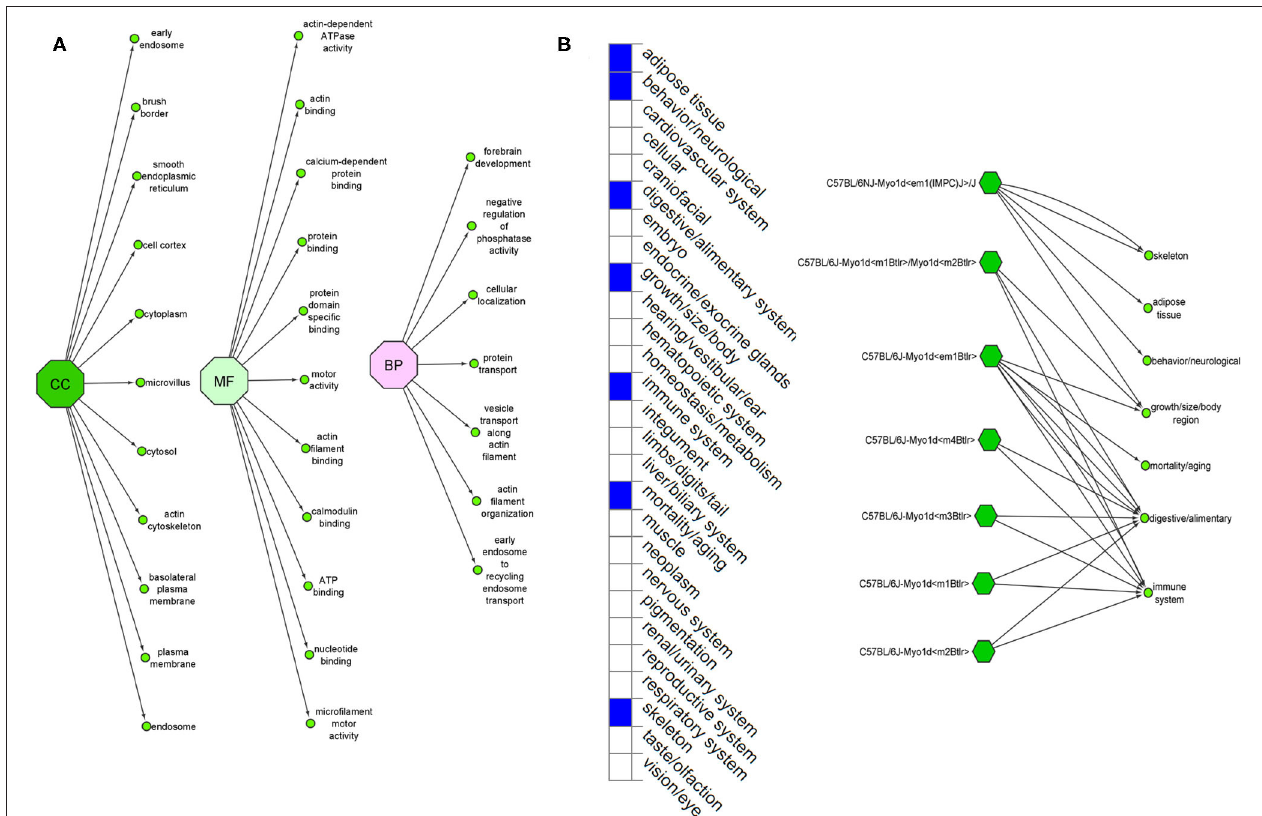
FIGURE 5 | (A) Ensembl function annotations of MYO1D . (B) Mouse MYO1D knockout analysis and phenotypic